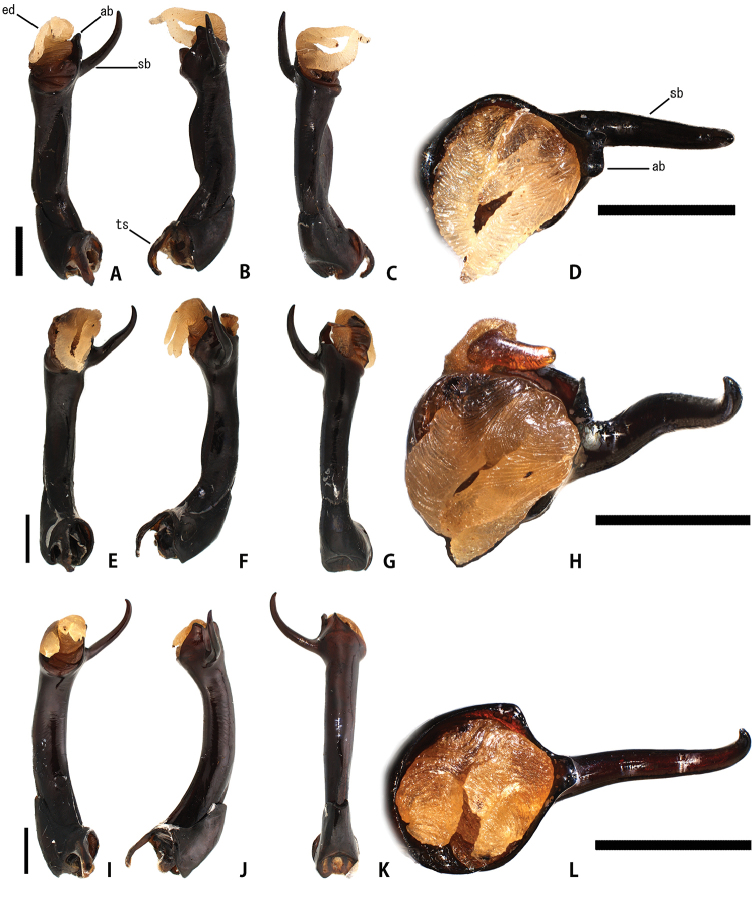
Aedeagus of Eumorphus spp. A–DE.costatusE–HE.wegneriI–LE.mirabilis sp. n. A, E, I ventral B, F, J lateral C, G, K dorsal D, H, I apical. Abbreviations: ab: apical branch ed: endophallus sb: subapical branch ts: tegminal strut. Scale bars: 1.0 mm.